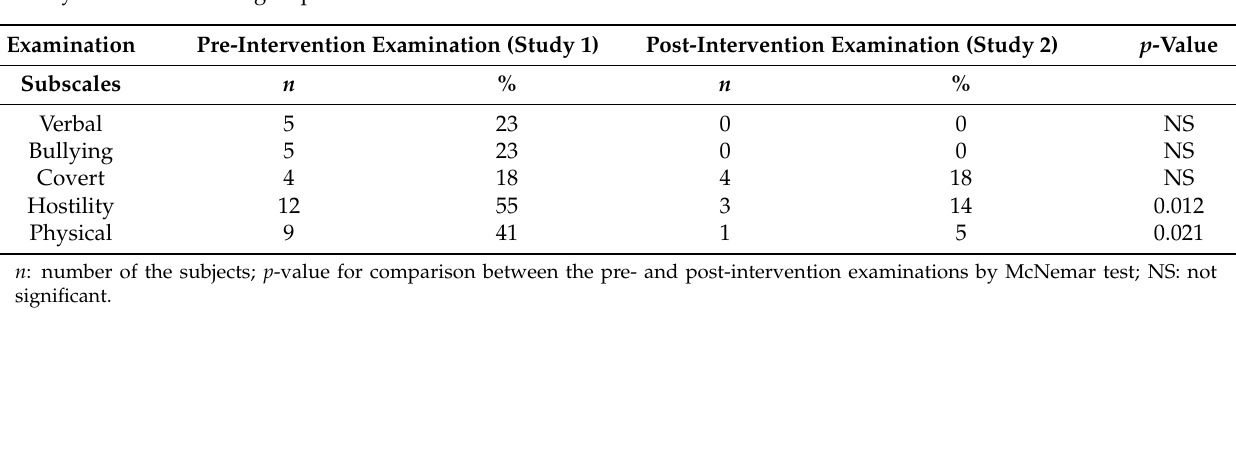
Table 5. Comparisons of the prevalence of children with high C-SARP aggression subscale scores between Study 1 and Study 2 in the reference group in Son